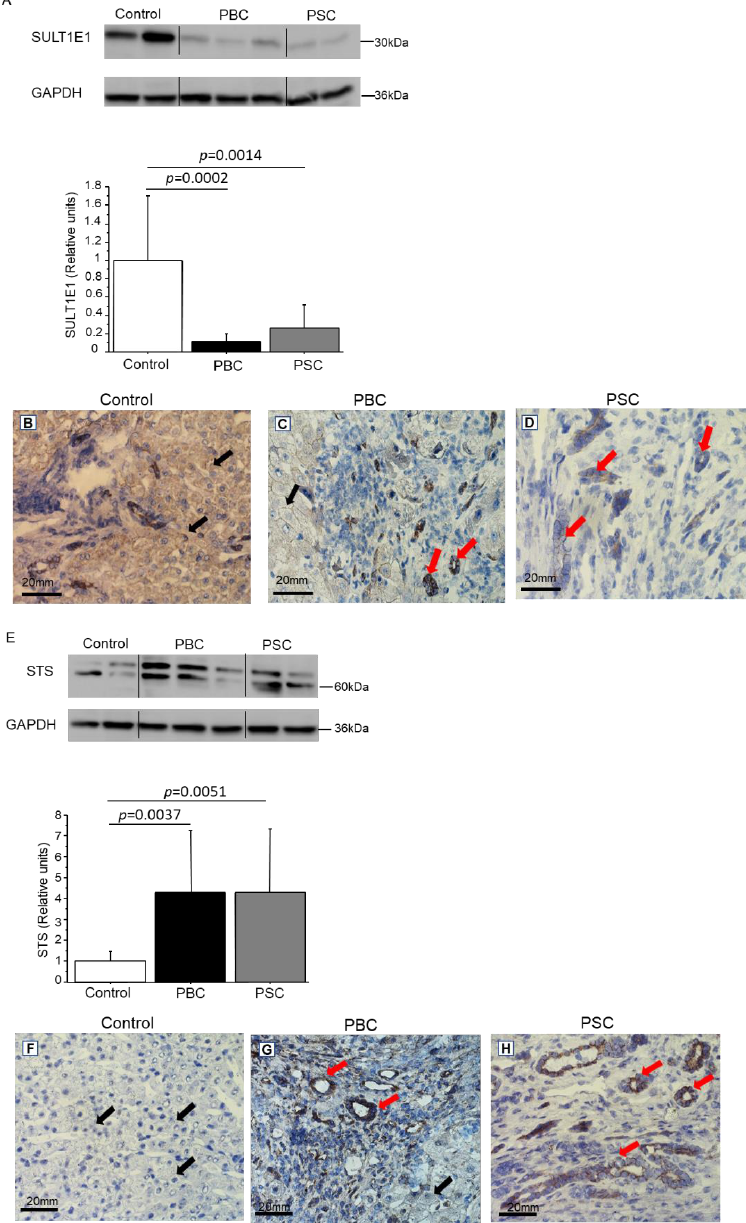
Figure 5. The level and expression of SULT1E1 and STS in cirrhotic (PBC, PSC) and control liver tissues. Western blot analysis revealed lower levels of SULT1E1 ( A ) and higher levels of STS ( E ) in cirrhotic PBC or PSC tissues in comparison to controls. The levels of each protein were normalized to GAPDH as a loading control. Immunohistochemical analysis showed that in control and cirrhotic tissues SULT1E1 was primarily present in cholangiocytes within the bile ducts (( B – D ); red arrows) and in hepatocytes (( B , C ); black arrows). Additionally, in cirrhotic tissues, STS was mainly present in cholangiocytes (( G , H ); red arrows). In control tissues, this protein showed nuclear localization in hepatocytes ( F ). Scale bar — 20 μ m.